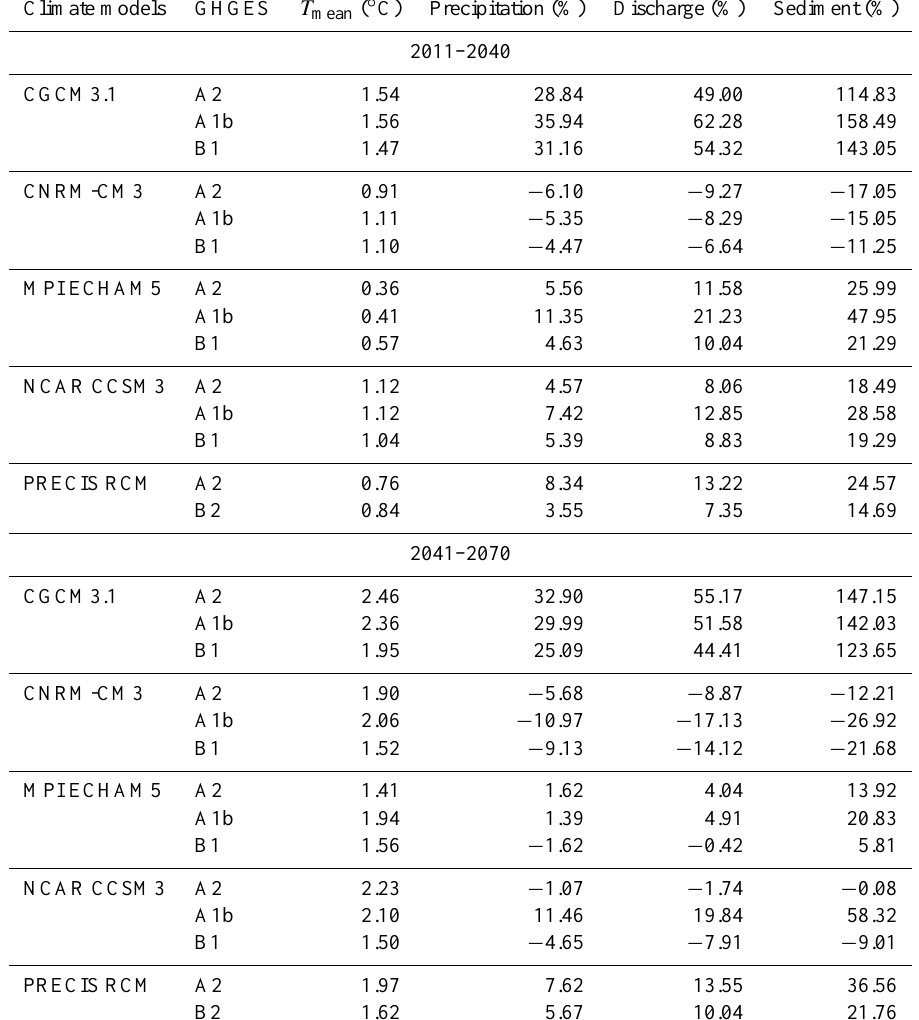
Table 5. Changes in average annual mean temperature, precipitation, discharges and sediment yield for all climate projections compared to the base period (1971–2000). Results are for 2011–2040 and 2041–2070